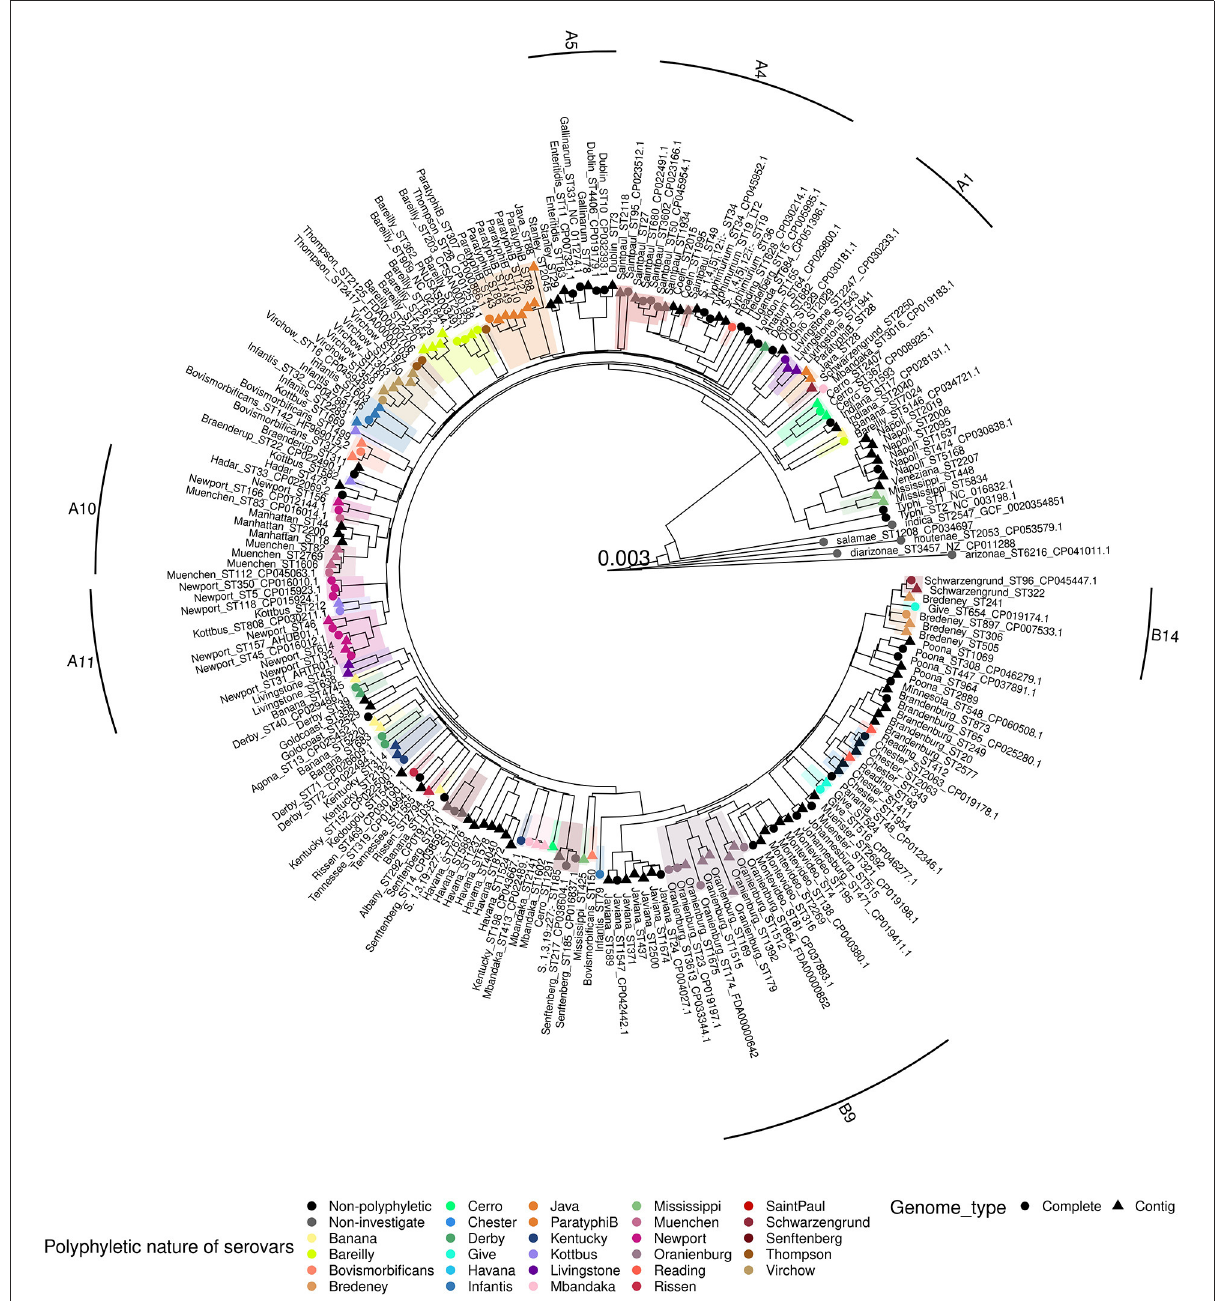
FIGURE3 Phylogenetic pan-genome kmer distance tree of the 219 genome subset of Salmonella . The tree is rooted on the Salmonella entrerica subsp. arizonae , diarizonae , houtenae , indica and salamae genomes. The tree is shown with branch lengths. Polyphyletic serovars are shaded in different colors. Complete genomes are indicated with circles and contigs with triangles. Labels contain the serovar and the MLST profile of each strain. The strongly supported subgroups listed in the Table 3 are highlighted in the margin of the tree. For example, A1 corresponds to the subgroup called “section Livingstone” in Table